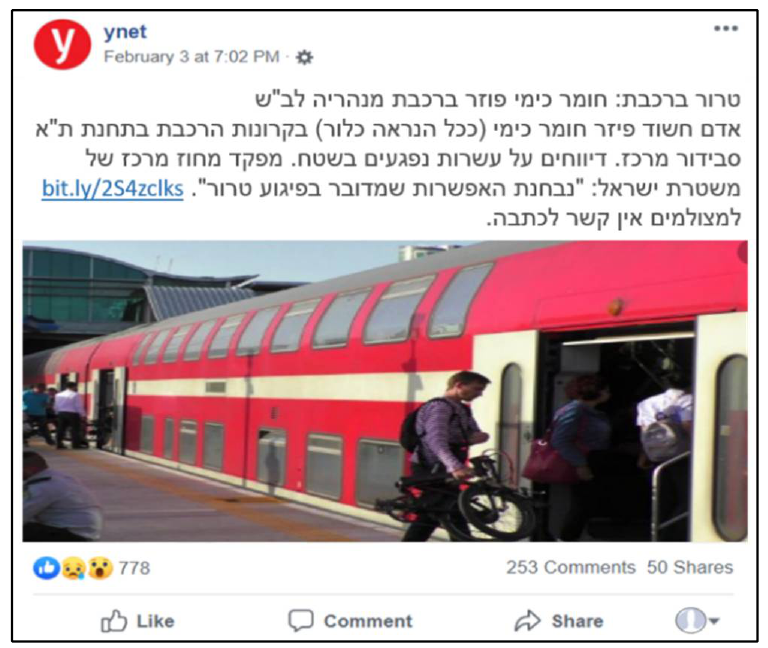
Figure A2. Screenshot of the mock social media news report for the chemical scenario.